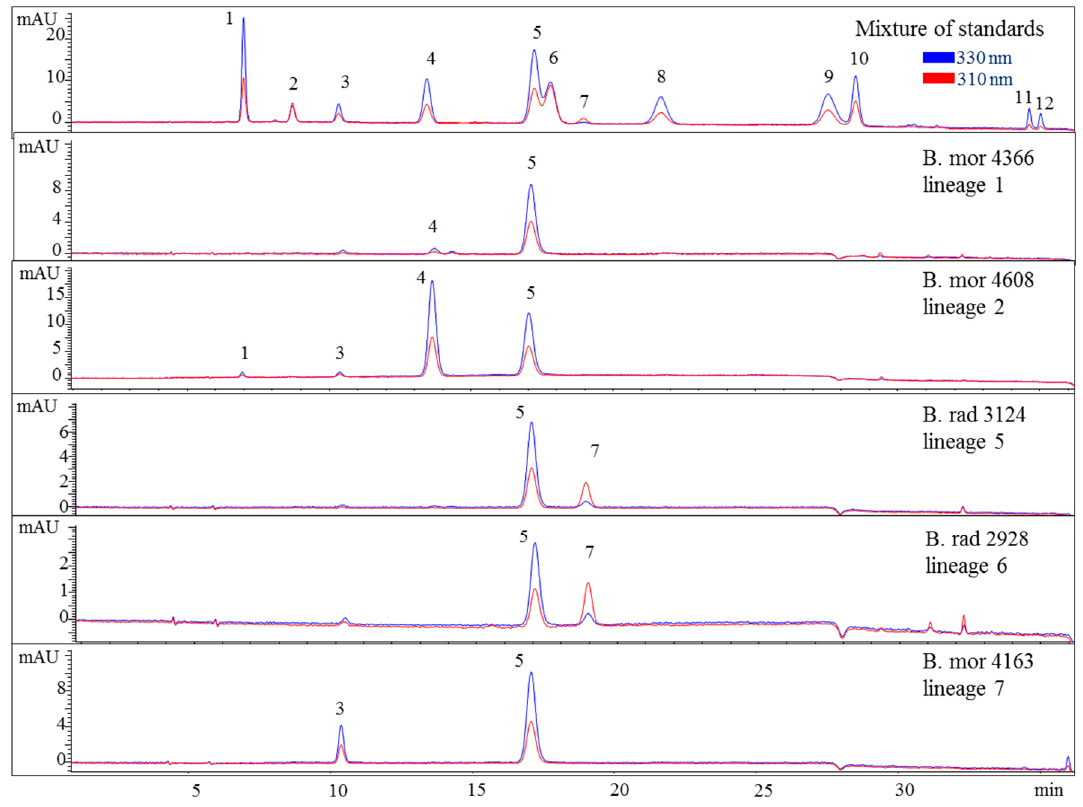
Figure 3. HPLC chromatograms of selected representatives of the lineages of the B . moritziana / B . radicans complex. Assignment of the compounds is according to Figure 1. The assignment of 5 as Aplysiapalythine A is tentative. Assignment of the species: B rad, B . radicans ; B mor, B . moritziana .